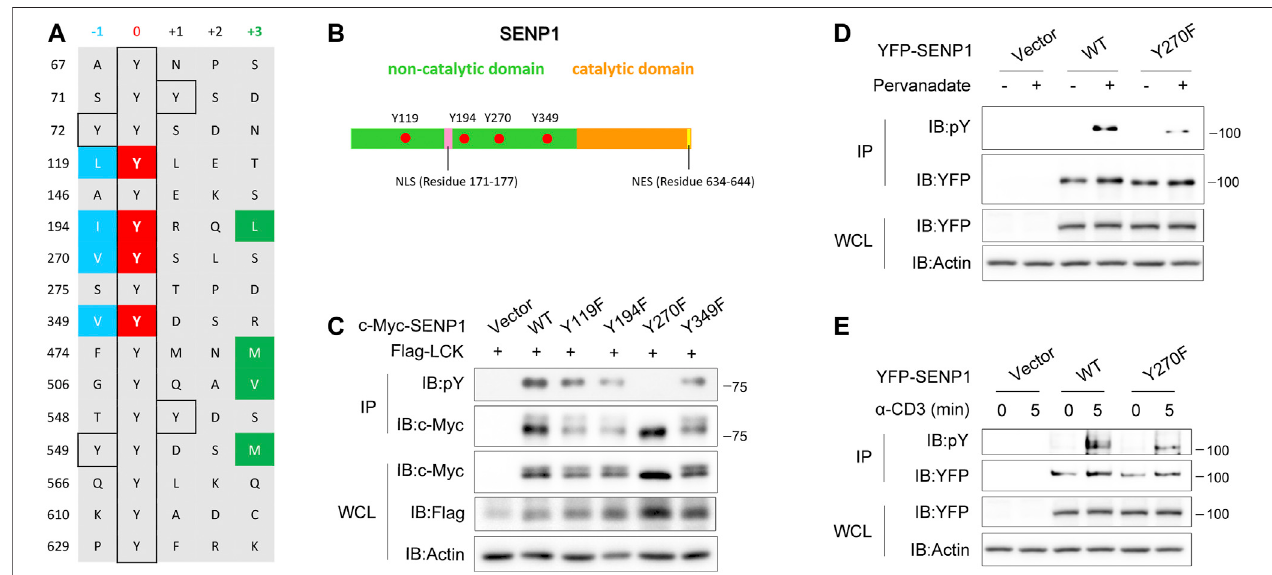
FIGURE 3 | Tyr270 on SENP1 is the key phosphorylation site by Lck. (A) Prediction of potential phosphorylation sites on SENP1 according to the sequence preference of Lck. Y119, Y194, Y270, and Y349 shown in red are candidate phosphorylation sites on SENP1. (B) Schematic illustration of SENP1 with the locations of Y119, Y194, Y270, and Y349. NLS, Nuclear localization sequence; NES, nuclear export sequence. (C) Anti-pY immunoblots of anti-c-Myc immunoprecipitates from HEK293T cells cotransfected with Flag-Lck and c-Myc-SENP1 WT or its mutants Y119F, Y194F, Y270F, and Y349F, respectively (top), and immunoblots of WCL ofHEK293Ttransfectants(bottom). (D) Immunoblotanalysisofpervanadate (tyrosinephosphataseinhibitor)-inducedtyrosinephosphorylationonYFP-SENP1inJurkat TAgcells. Anti-pY immunoblotsofYFP-SENP1immunoprecipitates fromJurkat TAgcells transfected with YFP-SENP1 WT orY270F mutant followedbytreatmentwith pervanadate at 37 ° C for 20 min (top), and WCL were immunoblotted as indicated (bottom). (E) Immunoblot analysis of anti-CD3-induced tyrosine phosphorylation on YFP-SENP1 in Jurkat TAg cells. Anti-pY immunoblots of YFP-SENP1 immunoprecipitates from Jurkat TAg cells transfected with YFP-SENP1 WT or Y270F mutant followed by stimulation with anti-CD3 for the indicated times (top), and WCL were immunoblotted as indicated (bottom).